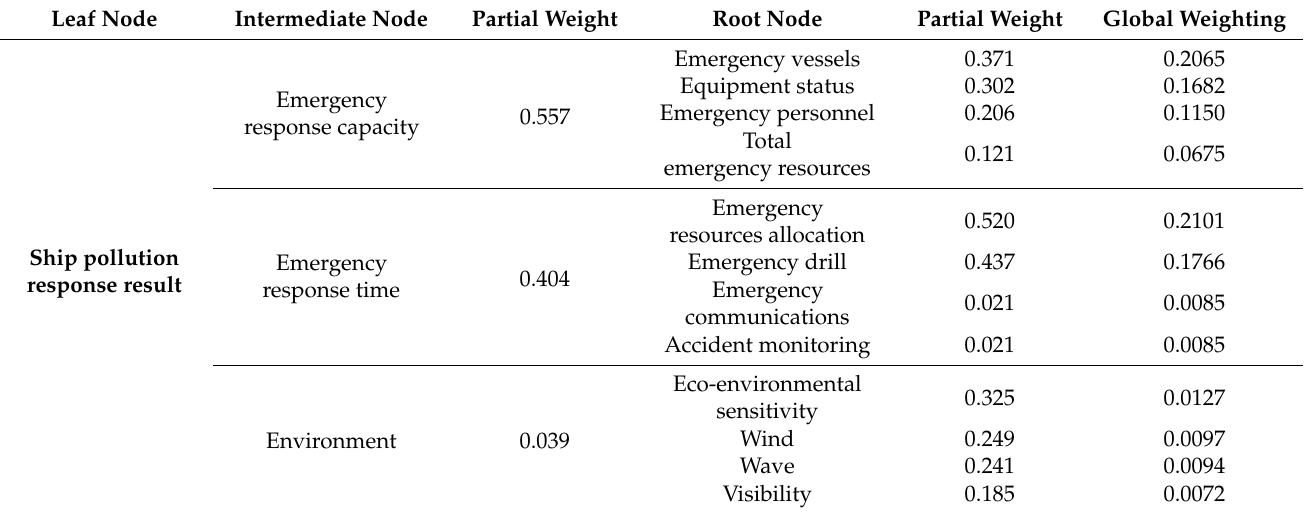
Table 4. Relative weights of all influencing